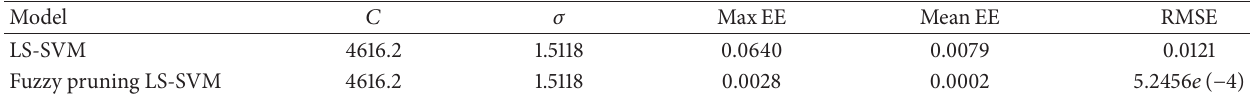
Table 1: One-dimension function predicted results.